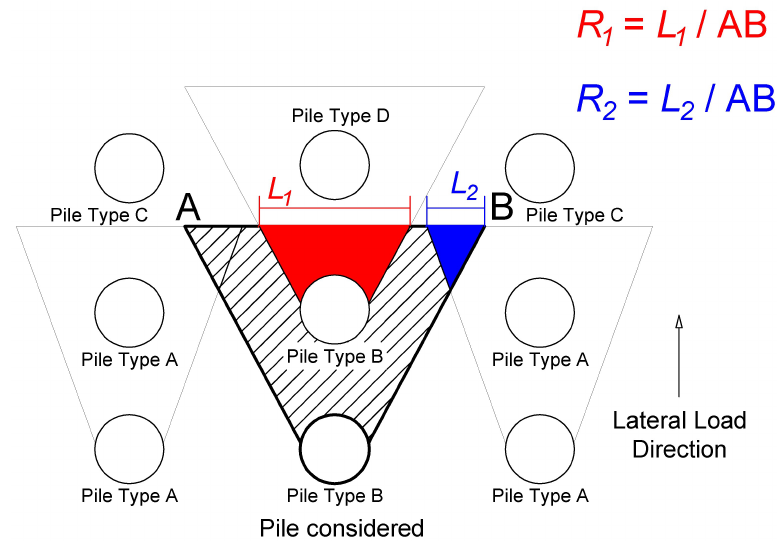
Figure 5. Lateral interaction for a specific pile in the group (similarly as described in the context of the so-called Strain Wedge Model